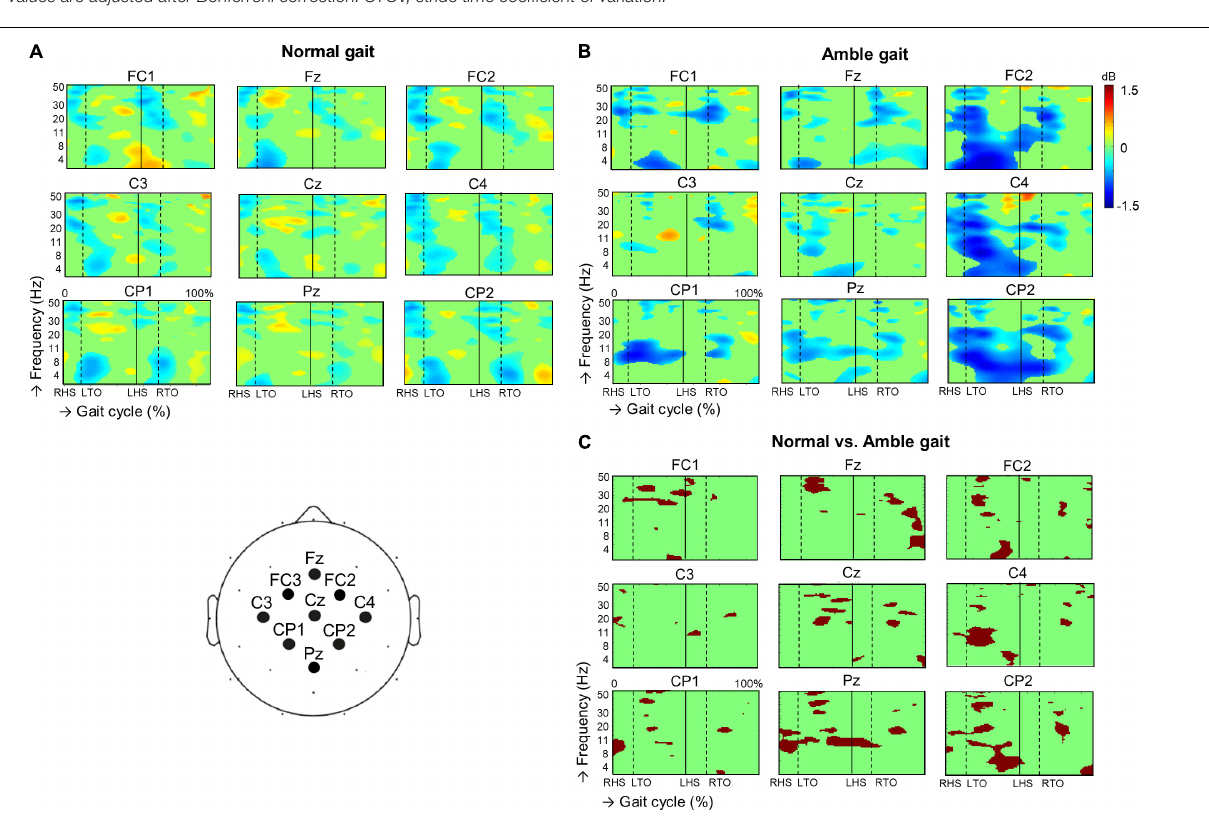
FIGURE 1 | Dynamic changes across the EEG frequency spectrum from electrodes located over the sensorimotor region during the successive stages of the gait cycle during (A) normal gait ( n = 35) and (B) amble gait ( n = 19). For each condition, significant ( p < 0.05) event related desynchronization is illustrated in blue and significant event related synchronization in red. Significant differences in ERSP between the two gait conditions were calculated for the 19 participants performing both normal and amble gait and is presented in (C) . Position of the EEG electrodes on the scalp is illustrated in the cartoon at the bottom left. ERSP, event related spectral perturbations; dB, decibel; RHS, right heel strike; LHS, left heel strike; RTO, right toe-off; LTO, left